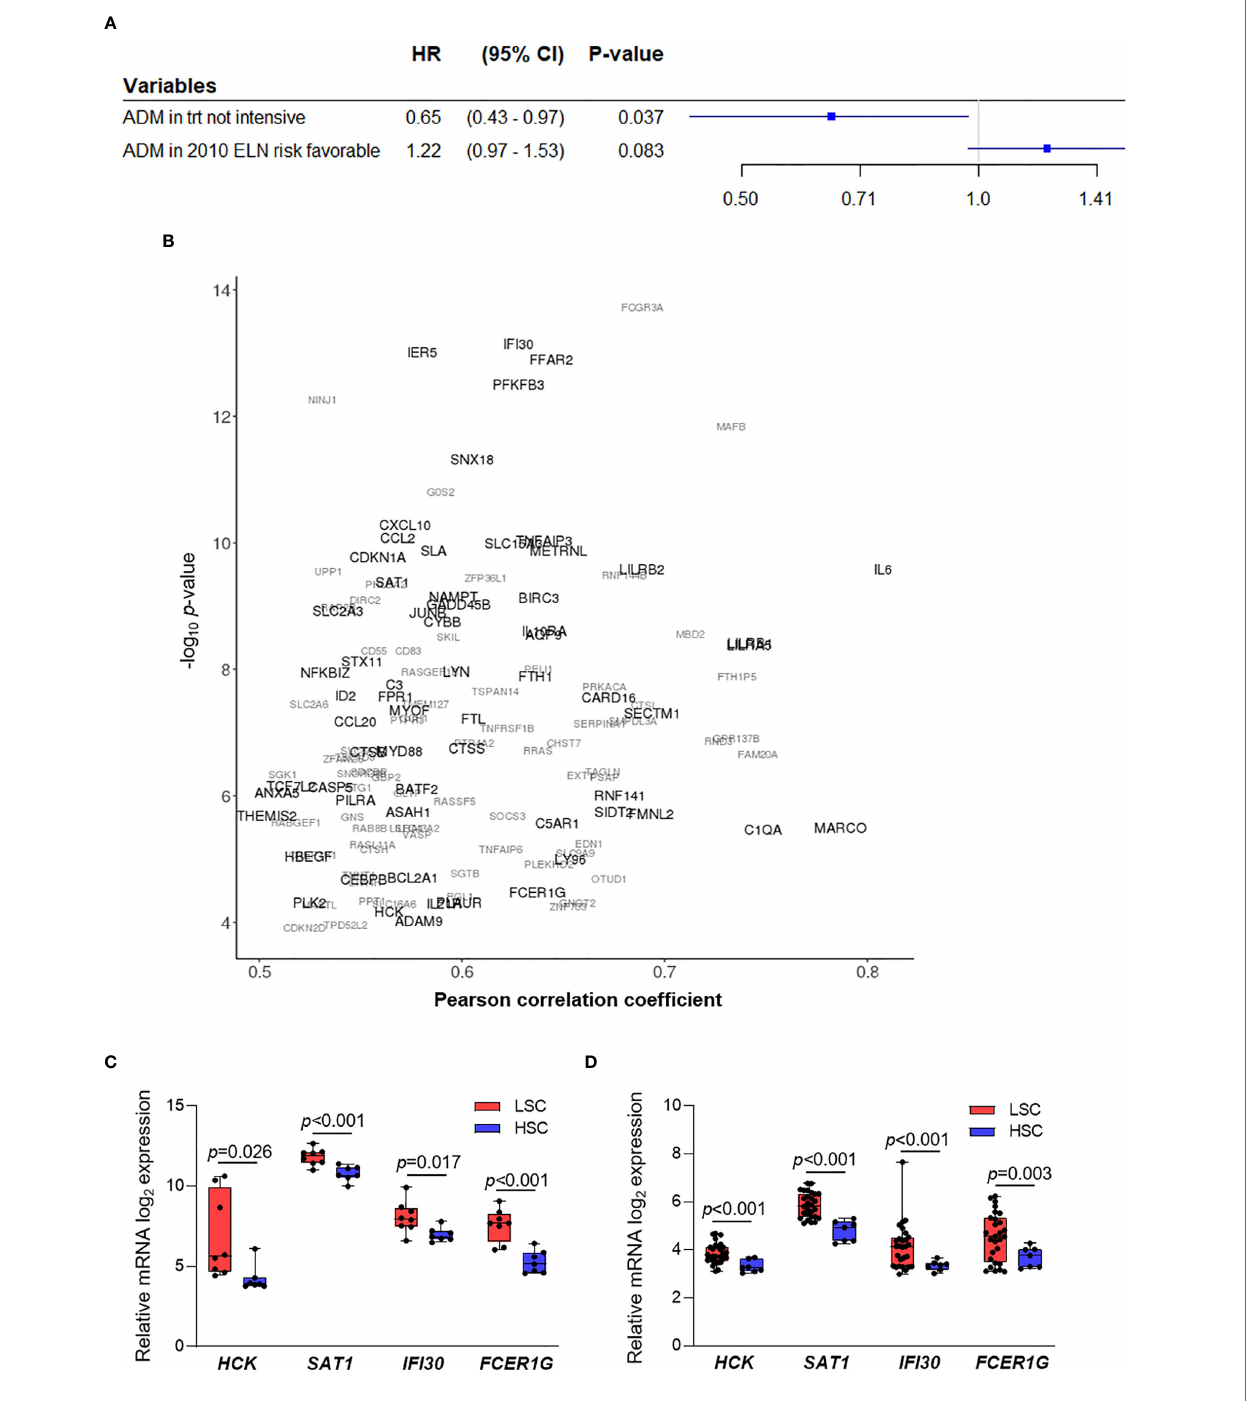
FIGURE 3 | ADM prognostic role and co-expressed genes in AML. (A) Results from two separate Cox regression models within the subgroup with 2010 ELN favorable risk (adjusting for age, n = 214) and within the subgroup receiving a not-intensive treatment (n = 64, HR, Hazard ratio, CI, con fi dence interval, trt, treatment). (B) Correlation analysis between ADM expression and the AML transcriptome across bone marrow samples from fi ve AML datasets (GSE6891, GSE13159, Beat AML, TCGA-LAML, NGS-PTL). Genes showing an absolute value of Pearson correlation coef fi cient ≥ 0.50 and a p value ≤ 0.05 in at least two cohorts were reported. Genes are represented according to the weighted arithmetic mean of the correlation coef fi cient and p value across the datasets. The scatter plot was generated with the R package ggplot2 (48) (version 3.3.1). (C) Transcriptional analysis of ADM co-expressed genes in LSC compared with HSC in the GSE24006 and (D) in the GSE117090 datasets (fold change ≥ 1.5 and p ≤ 0.05 were set as cut off). The boxes extend from minimum to maximum values, each individual value is plotted and the line represents the median